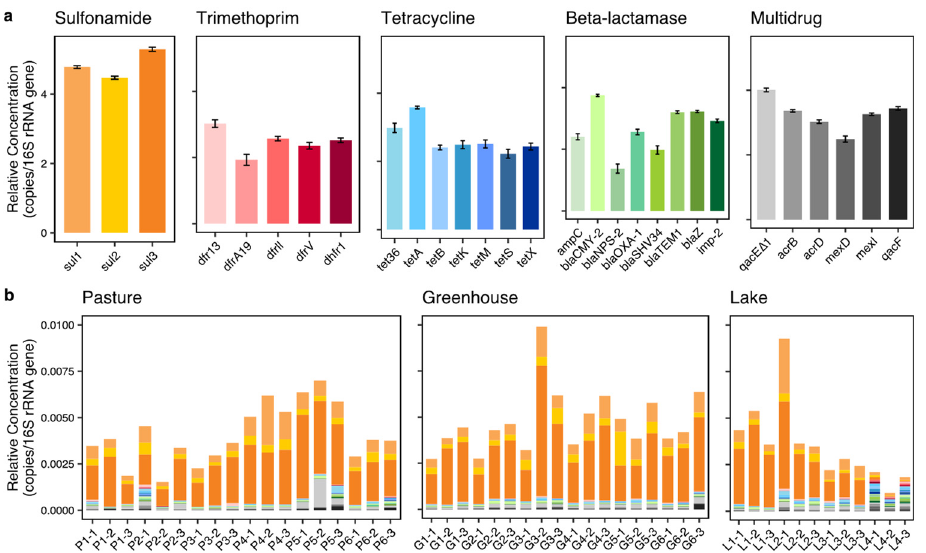
Figure 2. ARG concentrations. (a) Average of the relative concentrations [log 10 (x*10 8 +1) transformed, copies/16S rRNA gene] of each ARG in all 48 samples, with error bars on the top showing the standard errors (SE). Colors indicate ARGs, each color family represents an antibiotic class, sulfonamide (yellow), trimethoprim (red), tetracycline (blue), beta-lactamase (green) and multidrug (grey). (b) Relative ARG concentrations (copies/16S rRNA gene) of each sample. Row names indicate the land use type of the sampling location (P, pasture; G, greenhouse; L, lake) followed by the number of the sequence of locations and replicates, e.g., P1 (the first pasture location)-1 (the first sampling replication). Colors indicate ARGs in the same way as in (a) .